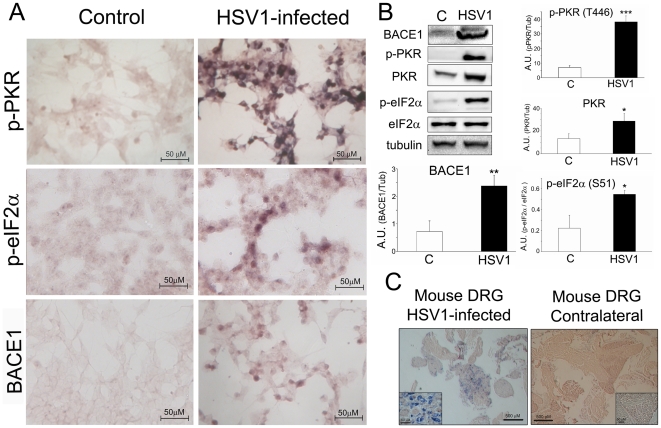
HSV1 infection activates PKR.SH-SY5Y cells were infected with HSV1 (1 pfu/cell, 24 h) or were not infected (controls). Immunocytochemistry analysis was carried with the following Abs: anti-p-PKR, anti-p-eIF2-alpha and anti-BACE1 (A). Protein extracts of SH-SY5Y cells infected with HSV1 (3 pfu/cell, 24 h) and uninfected cells (controls) were analysed by Western blotting using the following Abs: anti-BACE1, anti-p-PKR, anti-PKR, anti-p-eIF2-alpha, anti- eIF2-alpha and anti-tubulin. Bands were quantified by densitometric analysis. Results are expressed as the mean ± SEM of 3–4 independent experiments. * p<0.05, ** p<0.01, *** p<0.0005 by Student's t test (B). Sections from mouse dorsal ganglion root (DRG) were obtained from HSV1-infected mice. Contralateral uninfected ganglia were used as controls. Immunohistochemistry analysis was carried out to detect p-PKR (C).